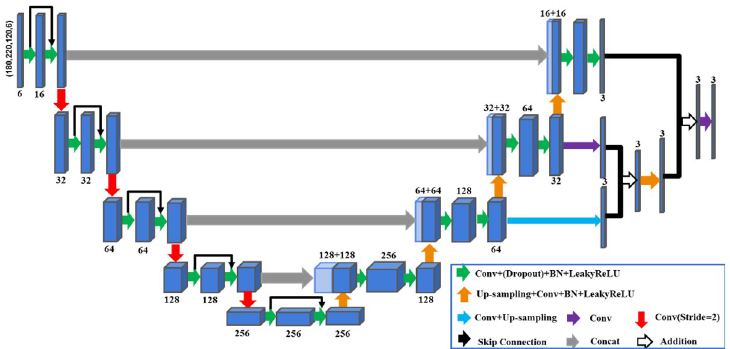
Fig 1. Illustration of the architect of 3D-MSResUnet. The last few cuboids shown in dark gray colors represent the mechanism for integrating multi-scale features maps from decoders.